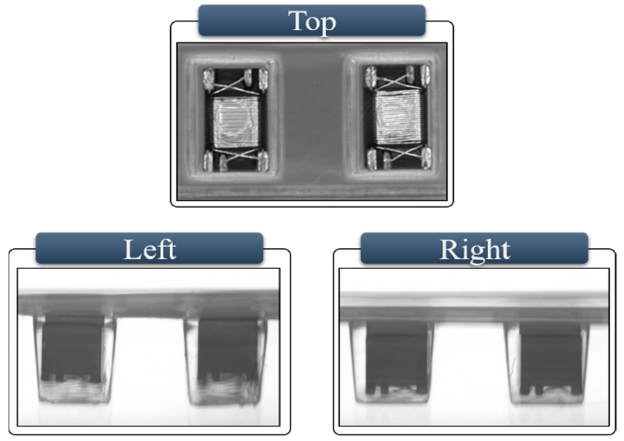
Figure 9. Example of coil datasets.